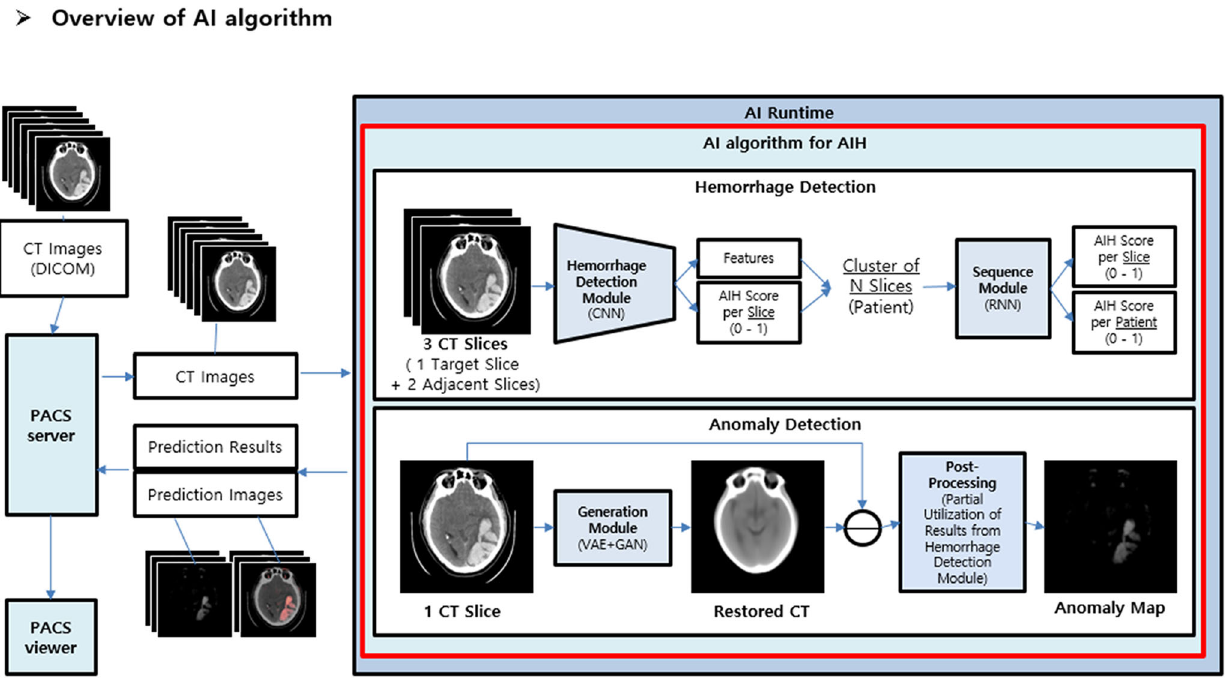
Fig. 4 Overview of the AI algorithm. The diagram shows the architecture of the proposed AI algorithm. This new AI algorithm combined a supervised haemorrhage detection process and an unsupervised anomaly detection process. In addition, a combined CNN-RNN architecture was applied in the haemorrhage detection process. The presence or absence is determined through the haemorrhage detection process. As a result of this haemorrhage detection process, the AI algorithm provides the AIH score in the patient-wise and slice-wise manner. The AI algorithm provides the anomaly map for AIH patients through the subtraction between the original CT image and restored CT image (arti fi cially generated normal image based on the unsupervised training from normal dataset) and postprocessing. The average additional time to access the AI-assisted CT images on PACS viewer was 97.4 seconds. Time from PACS server to AI, AI processing time, and time from AI to PACS viewer were 54.6 seconds (range, 37 – 91 seconds), 11.8 seconds (range, 0.8 – 90.6 seconds), 31.0 seconds (range, 30 – 33 seconds). Note.